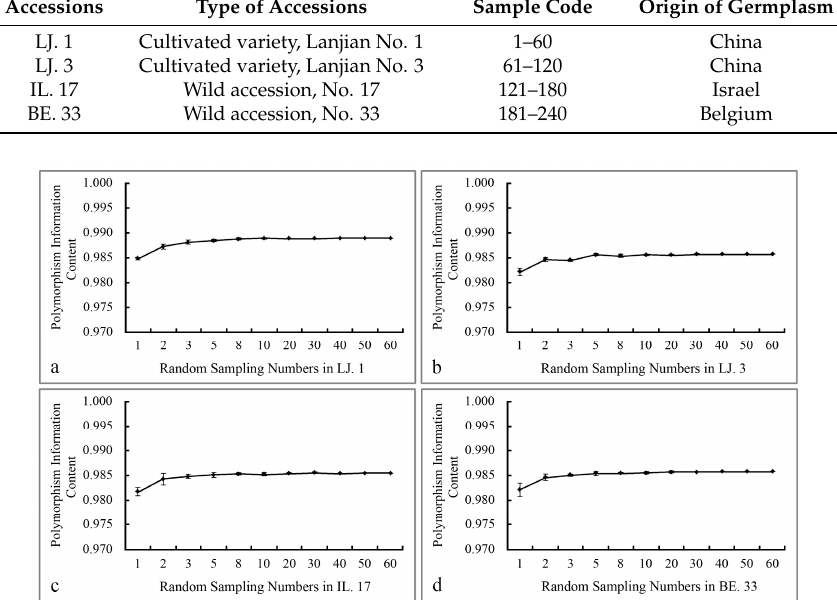
Table 1. Names of common vetch accessions and their origins.